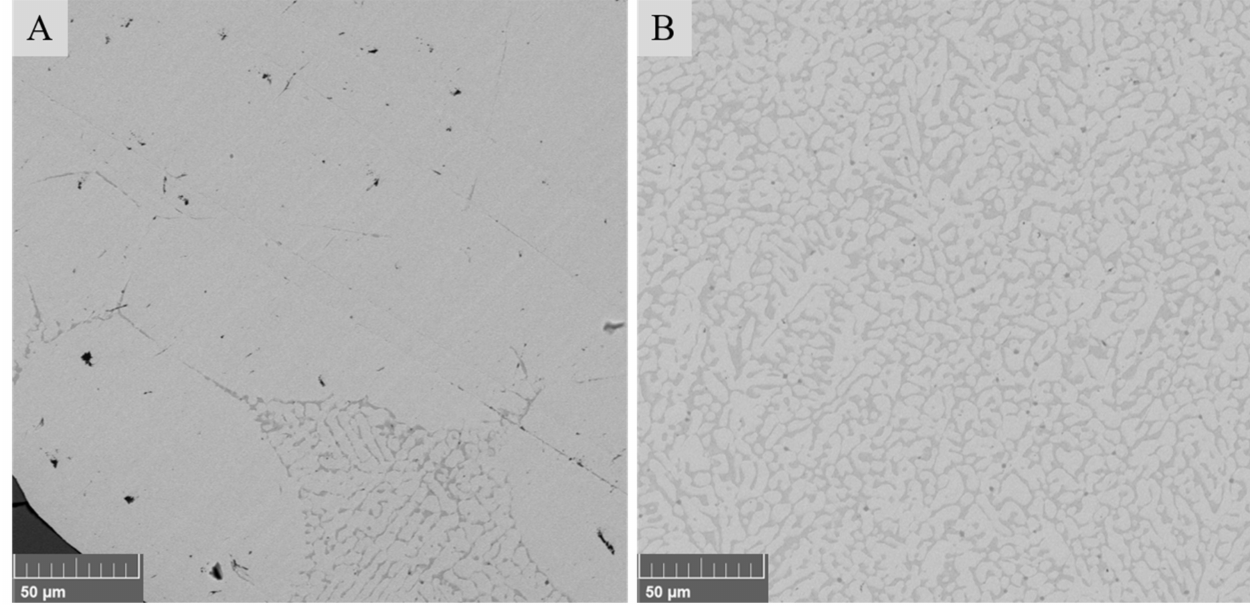
Figure 3. Microstructures of metal alloy ( A ) and matte ( B ) in the sample after 10 min contact time with 10 wt.% of SBs in the starting